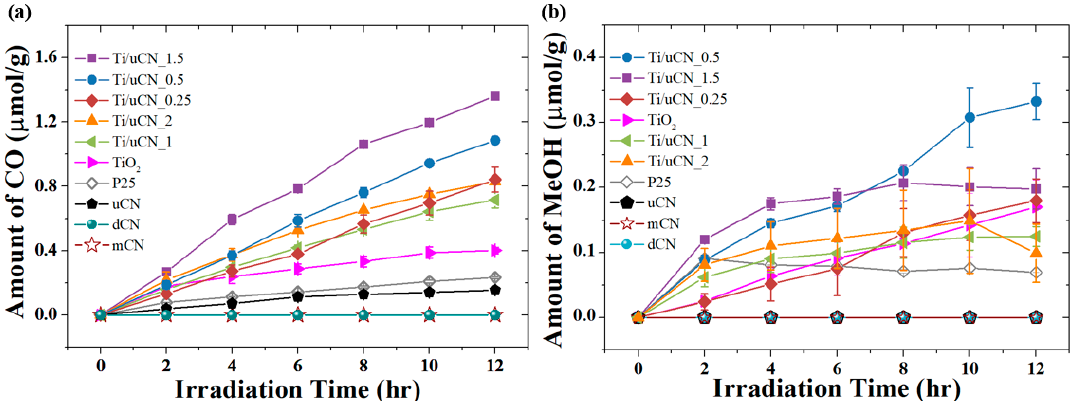
Figure 5. Time courses of ( a ) CO and ( b ) MeOH yields from each sample under LED